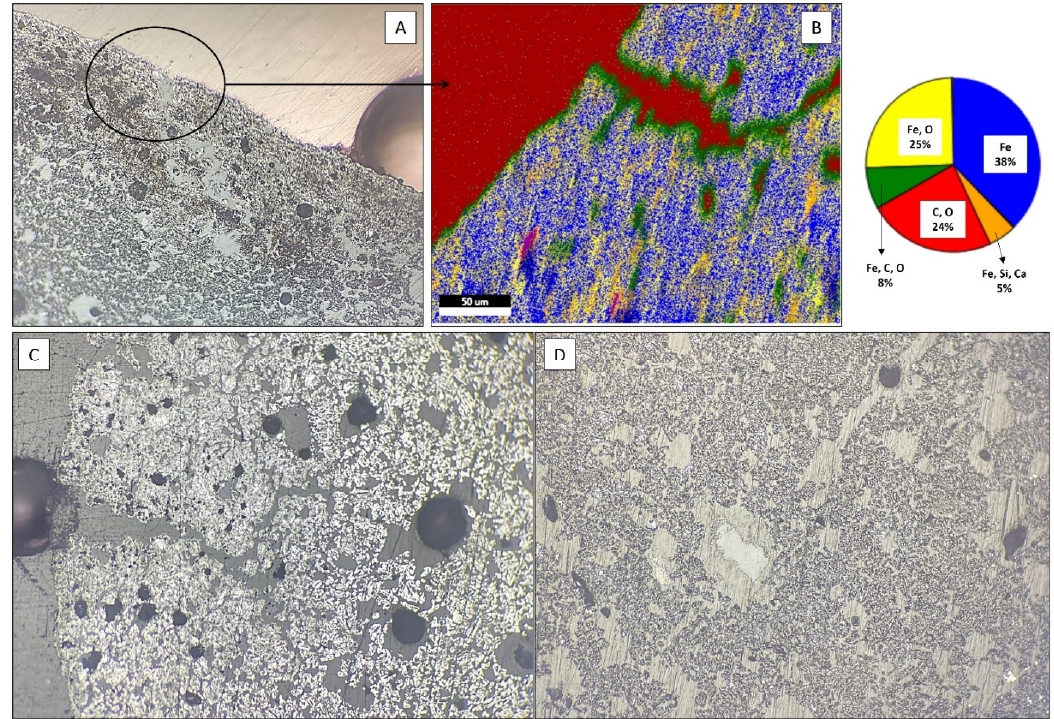
Figure 9. ( A ) Optical microscope ×10 image showing Fe 3 C phase for pellets reduced with H 2 /CO = 56/36 gas mixture, ( B ) SEM-EDAX map along with pie chart of the observed element phases in the image, Optical microscope ×40 image showing Fe 3 C phase in ( C ) shell region & ( D ) Optical micro- scope ×100 image of core region for pellets reduced with H 2 /CO = 56/36 gas mixture.